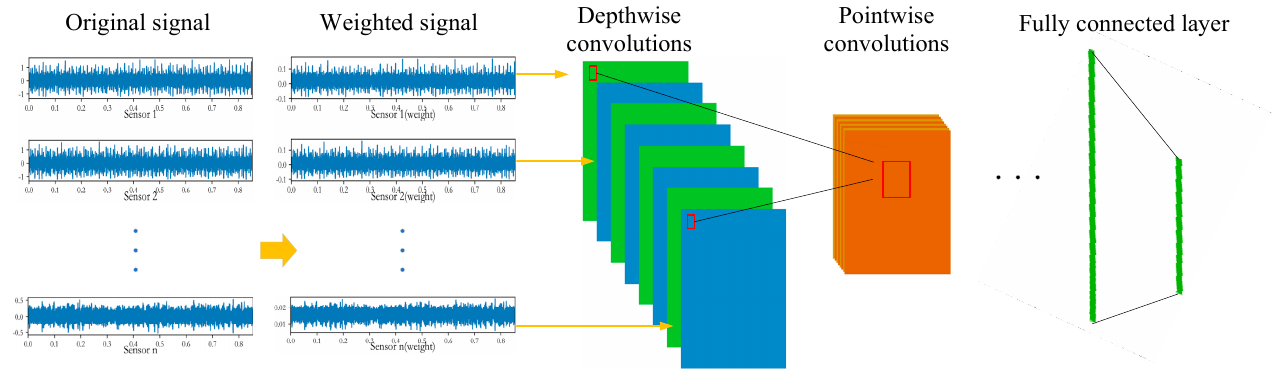
Figure 4. The architecture of proposed method.